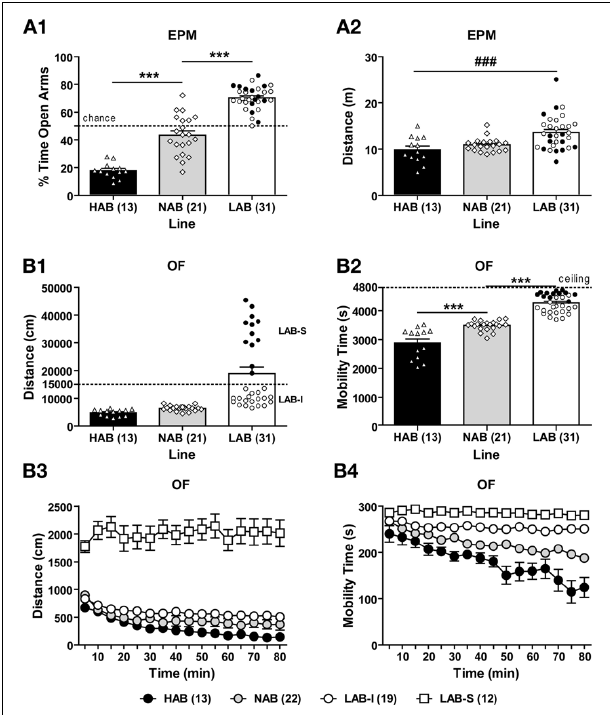
FIGURE 3 | Hyperlocomotion in low anxiety-related behavior (LAB) mice. (A1) Mice originating from selectively bred lines showed low (LAB), intermediate (NAB), or high (HAB) levels of innate anxiety on the elevated plus-maze (EPM). (A2) LAB mice were more active than HAB mice in the EPM test. (B1) In the open field (OF) test (80-min exposure), LAB mice traveled longer distance compared to HAB and NAB mice. In addition, they showed two clusters of total distance traveled which could be distinguished by a threshold of 15000 cm (dashed line), revealing LAB-intermediate (LAB-I; open circles) and LAB-strong (LAB-S; close circles) mice. Interestingly, LAB-I and LAB-S mice did not differ in anxiety-related behavior and distance traveled assessed in the EPM test (cf. A1 and A2 ). (B2) LAB-I mice spent significantly more time in mobility than HAB and NAB mice, but less than LAB-S mice. Exploratory behavior over the course of testing was measured in terms of (B3) distance traveled and (B4) mobility time in 5-min bins for the 80-min exposure. LAB-S mice displayed much higher levels of distance traveled than HAB, NAB, and LAB-I mice, with an additional significant difference between LAB-I and HAB mice. In addition to distance traveled, mobility time also significantly differed between all four lines. Notably, in contrast to pronounced habituation to the OF in HAB, NAB, and LAB-I mice, LAB-S mice showed virtually no habituation over the course of the entire exposure, if locomotion and mobility were considered. Mean ± SEM. ∗∗∗ p < 0 . 001 vs. NAB; ### p < 0 . 01 vs. HAB (ANOVA followed by post-hoc Newman–Keuls